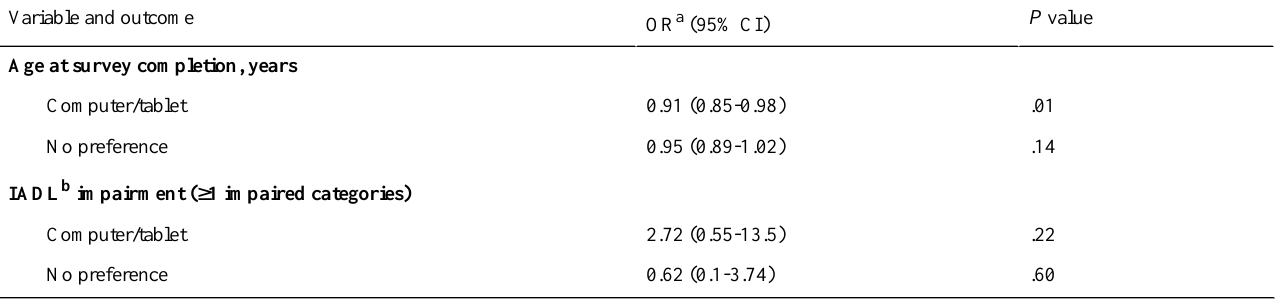
P valueOR a (95% CI)Variable and outcome